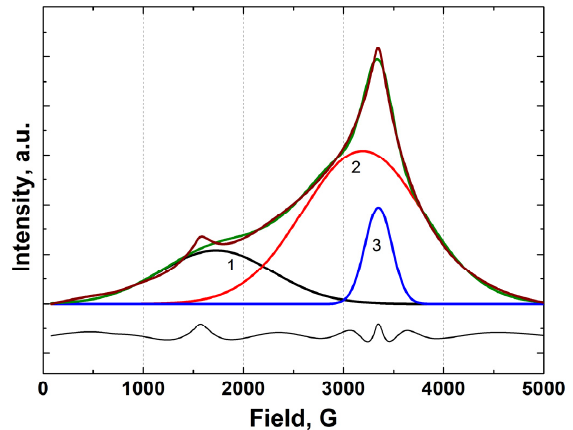
Figure 13. Deconvolution of the integral EPR spectrum of the FA-S2-1-300 sample (measured at 8 K) into three spectral lines. Black line—the reduced error of the decomposition. Next, the values of the integral intensity of each line I were obtained, and the values of the parameter (I·T) were calculated for different Ts in the range (8 – 90) K (Figure 14).